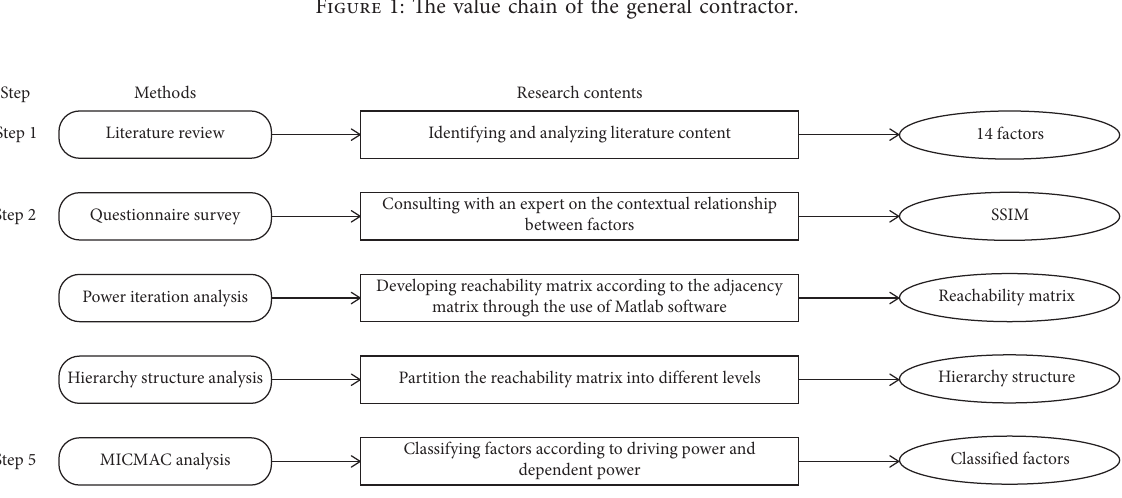
Figure 2: Procedures of this research.